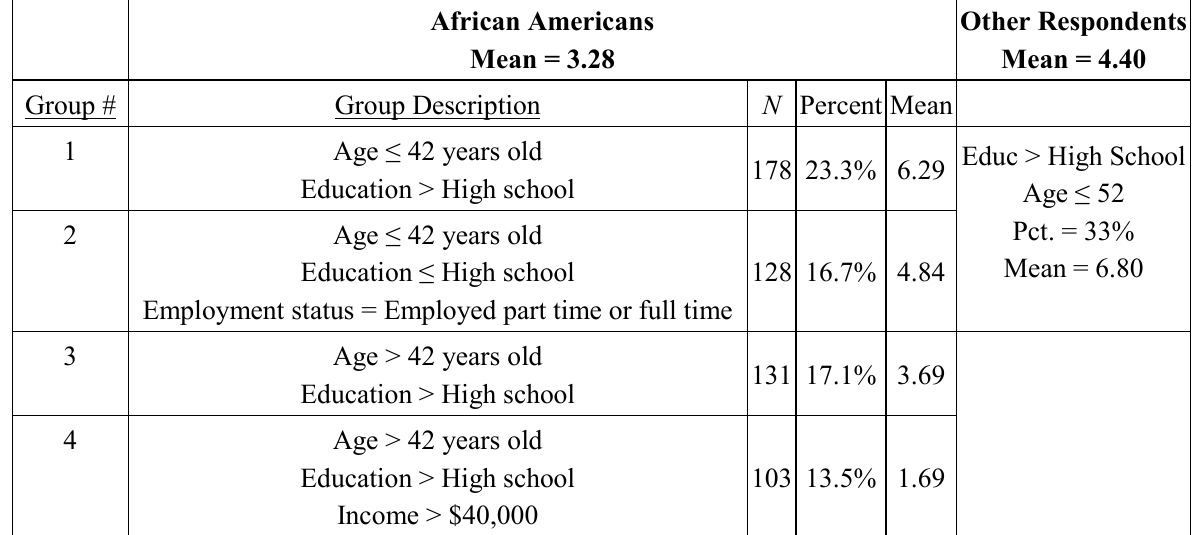
Table 4. CART analysis for basic